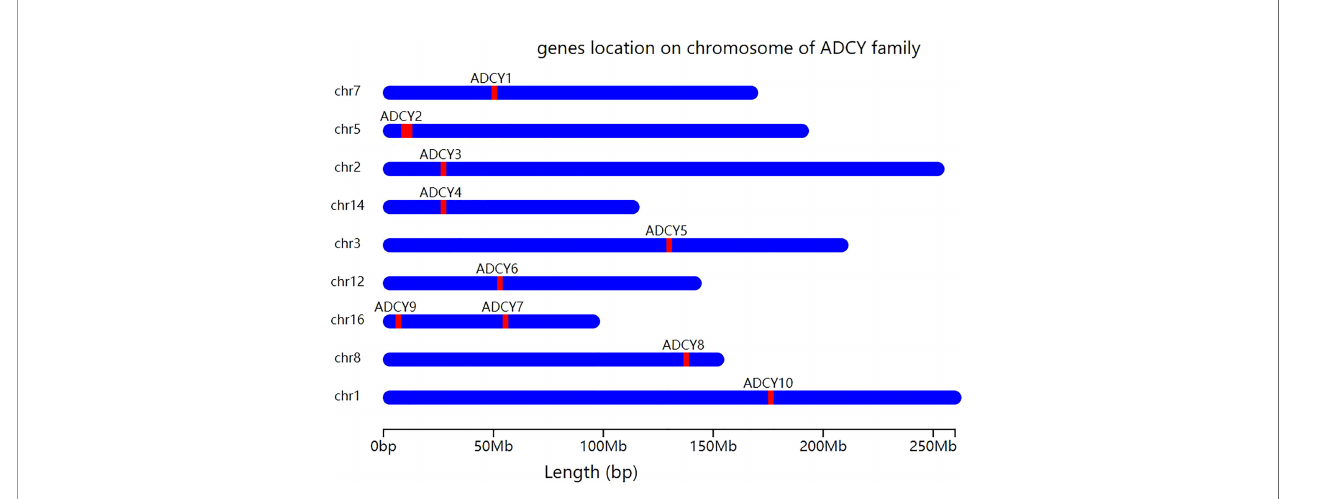
FIGURE 1 | Chromosomal localization of ADCY gene isoforms. Except for ADCY7 and ADCY9 , which are both located on chromosome 16, all other ADCY subtypes are located on different chromosomes. ADCY1 is located on chromosome 7, ADCY2 on chromosome 5, ADCY3 on chromosome 2, ADCY4 on chromosome 14, ADCY5 on chromosome 3, ADCY6 on chromosome 12, ADCY8 on chromosome 8, and ADCY10 on chromosome